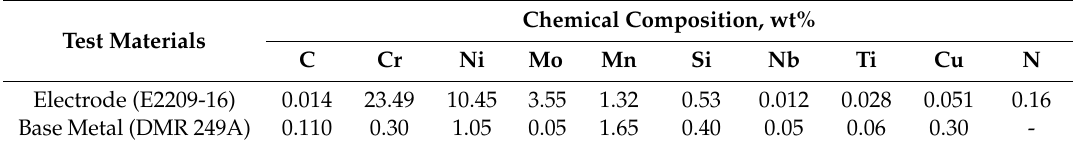
Table 1. Chemical elements of material grade DMR 249A and electrode E2209-16.